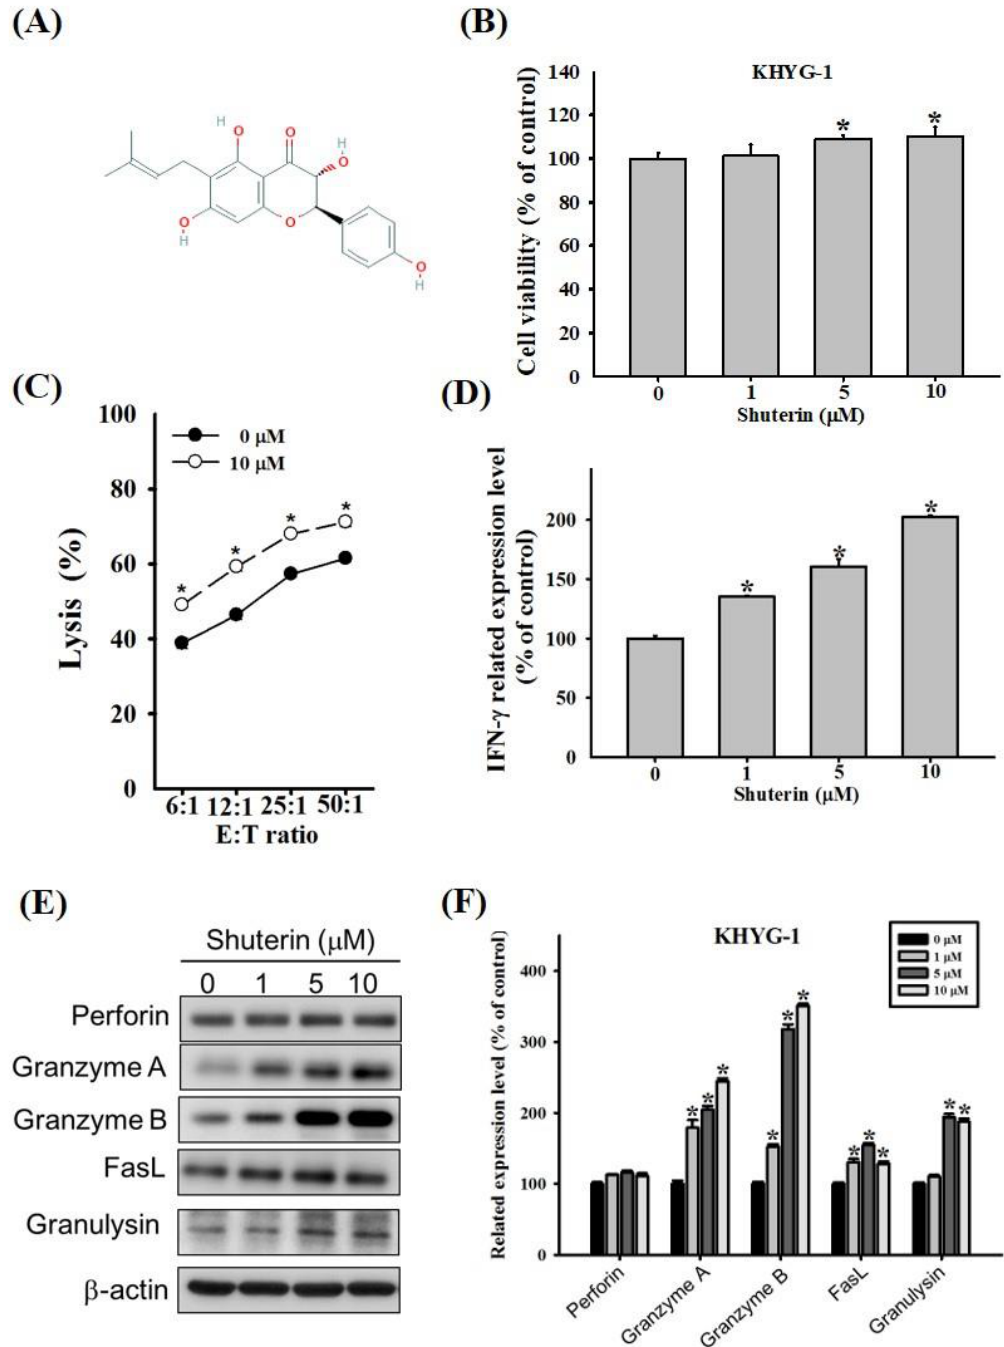
Figure 1. Shuterin enhanced the cytolytic activity of KHYG-1 cells. ( A ) Chemical structure of shuterin. ( B ) KHYG-1 cells were treated with shuterin for 72 h and then subjected to WST-8 assays for cell viability assessment. ( C ) Cytolytic effects of KHYG-1 cells treated with (or without) 10 µM shuterin for 24 h on K562 cells. Cytotoxicity was determined through the Calcein AM release assay. ( D ) Levels of IFN- γ in the culture supernatants of KHYG-1 cells treated with the indicated dose of shuterin for 24 h, then measured through enzyme-linked immunosorbent assay (ELISA). ( E ) After 24 h of shuterin treatment, the cytotoxic effectors of the KHYG-1 cells were analyzed through western blotting. ( F ) ImageJ was used for protein quantification; the levels of all proteins were normalized to that of β -actin. Data are presented as the mean ± standard deviation (n = 3) of three independent experiments. * p < 0.05 V.S. control.